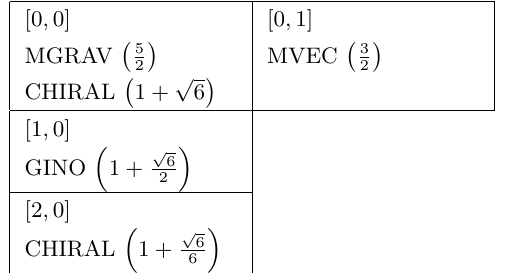
Table 7 . Supermultiplets at KK level n = 0 for the N = 1 G 2 -invariant AdS 4 solution of type IIA.